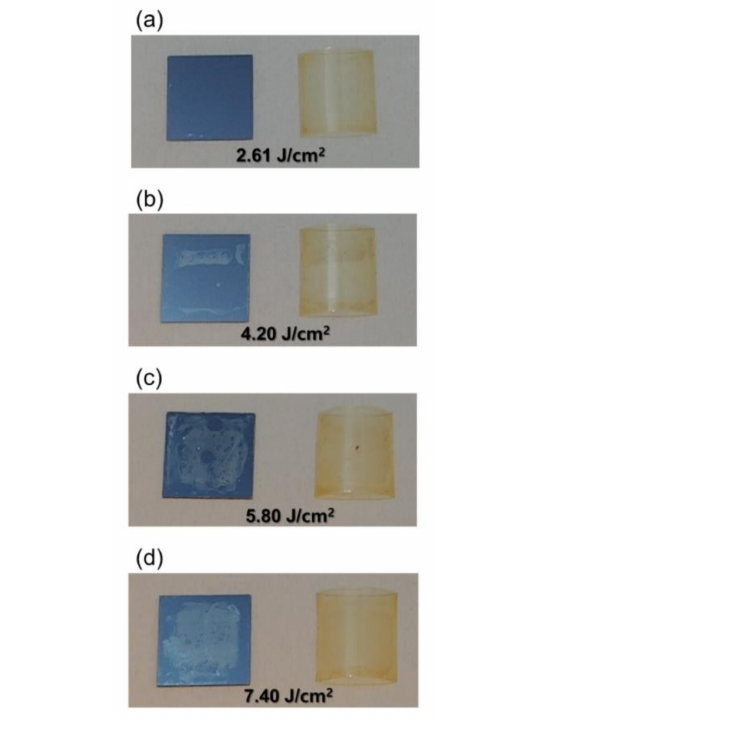
Figure 6. Lift-o ff characteristics according to XFL energy: ( a ) 2.61; ( b ) 4.20; ( c ) 5.80 and ( d ) 7.40 J / cm 2